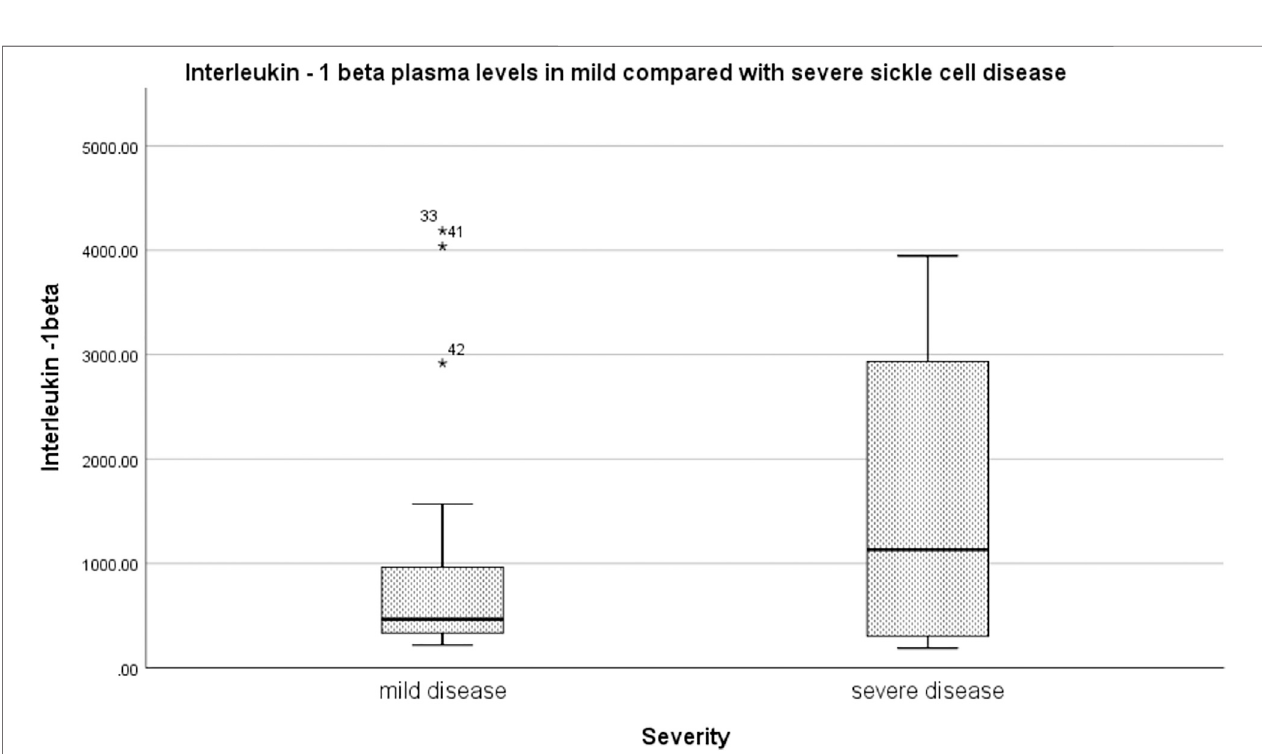
FIGURE 3 | Variation of plasma concentration (pg/ml) of IL-1 β with SCD severity. The thick horizontal line in each box represents the median value of IL-1 β for the disease severity group.